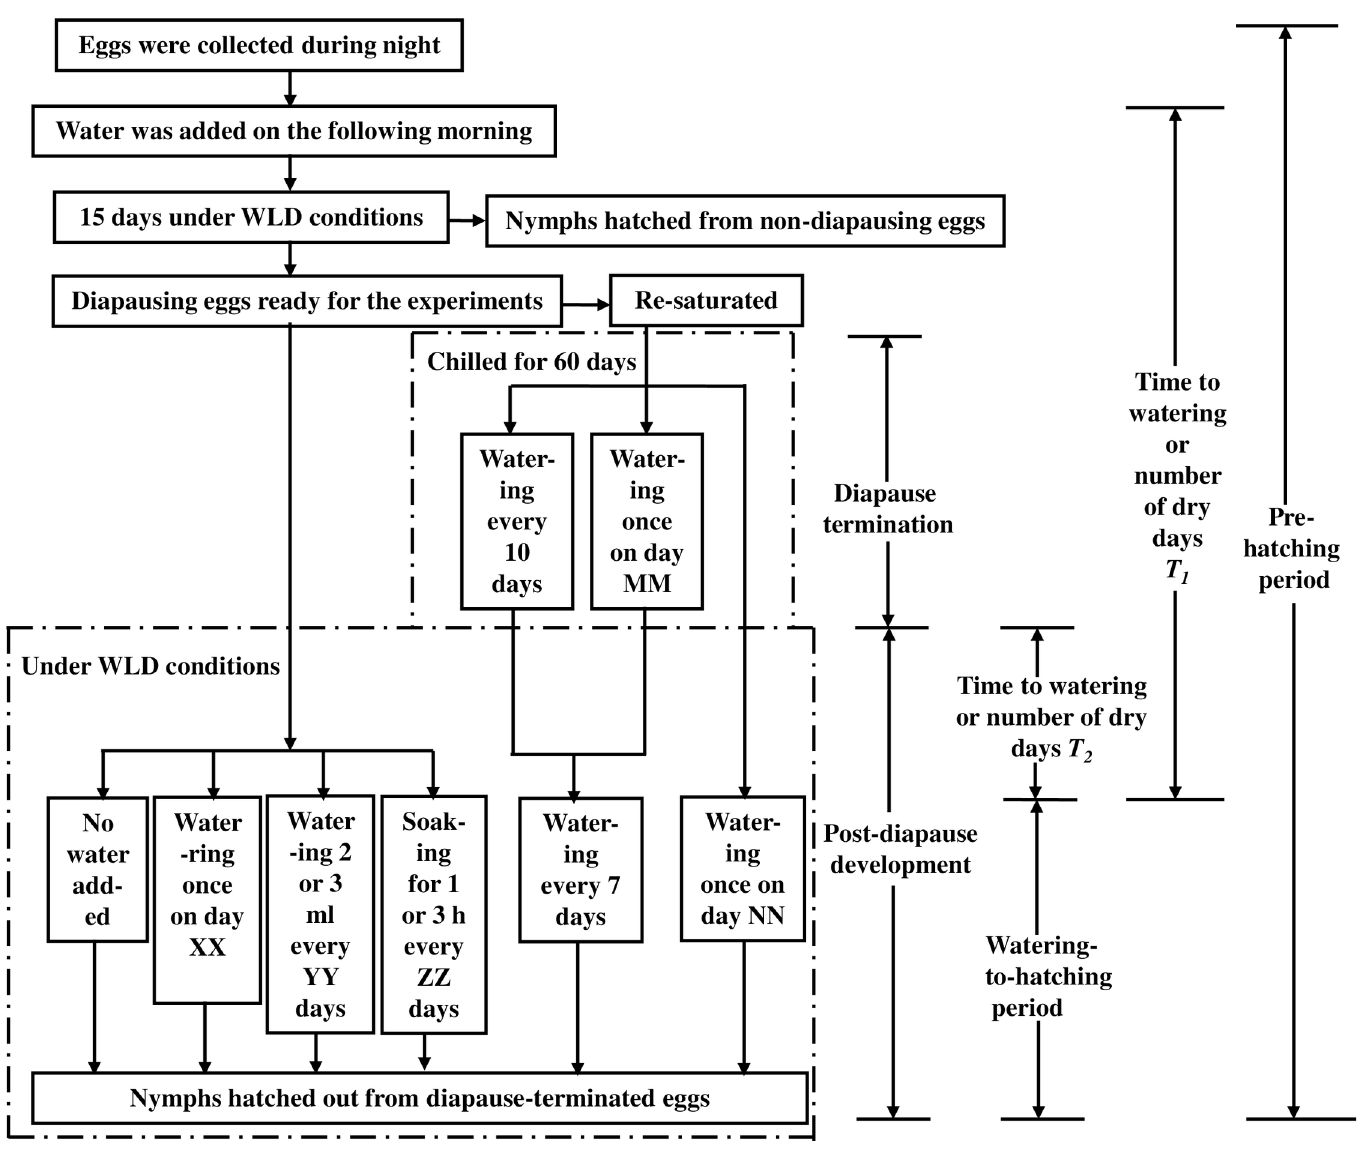
Fig 1. Flow chart showing water treatments during the diapause/post-diapause stage under warm long-day conditions, during the diapause termination (chilling) stage, and during the post-diapause stage (from transfer to WLD conditions after chilling until the hatching of nymphs). Watering once on day XX denotes watering on day 24, 35, 53, 63, 76, 84, 95, or 109 of incubation, respectively. Watering 2 or 3 ml every YY days means watering with either 2 or 3 ml water every 3 (watering with only 2 ml), 5, 10, 15, 20 and 30 days, respectively. Soaking for 1 or 3 h every ZZ days means soaking eggs for either 1 or 3 h every 5, 10 and 15 days, respectively. Watering once on day MM denotes watering once on day 0, 10, 20, 30, 40 or 50 of chilling, respectively. Watering once on day NN denotes watering once on day 0, 4, 6, 8, 10, 12, 14, 16, 18, 20 or 22 after transfer to WLD conditions,